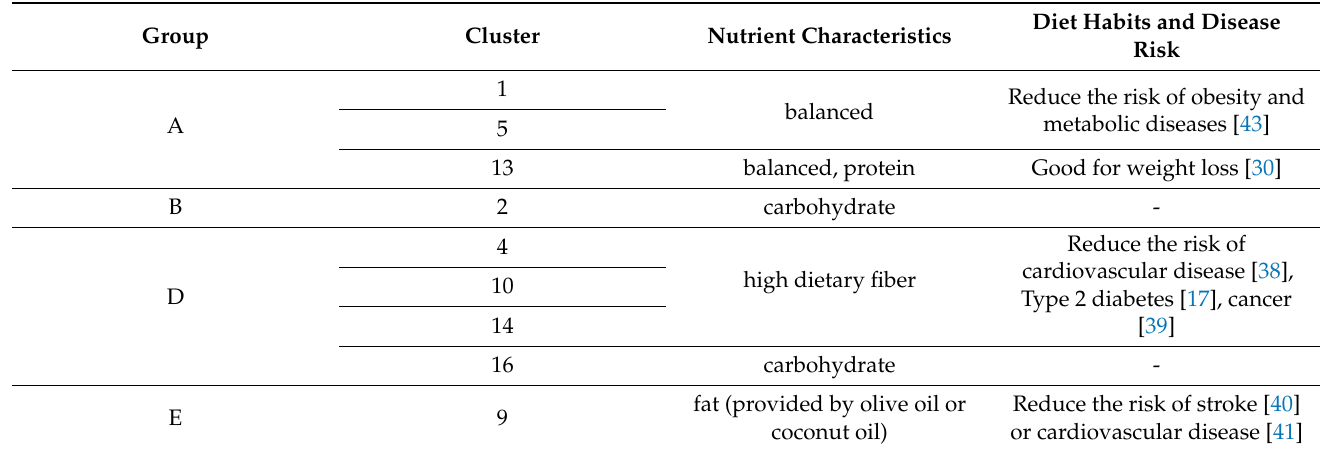
Table 10. Clusters and groups that conform with principles of healthy diets.